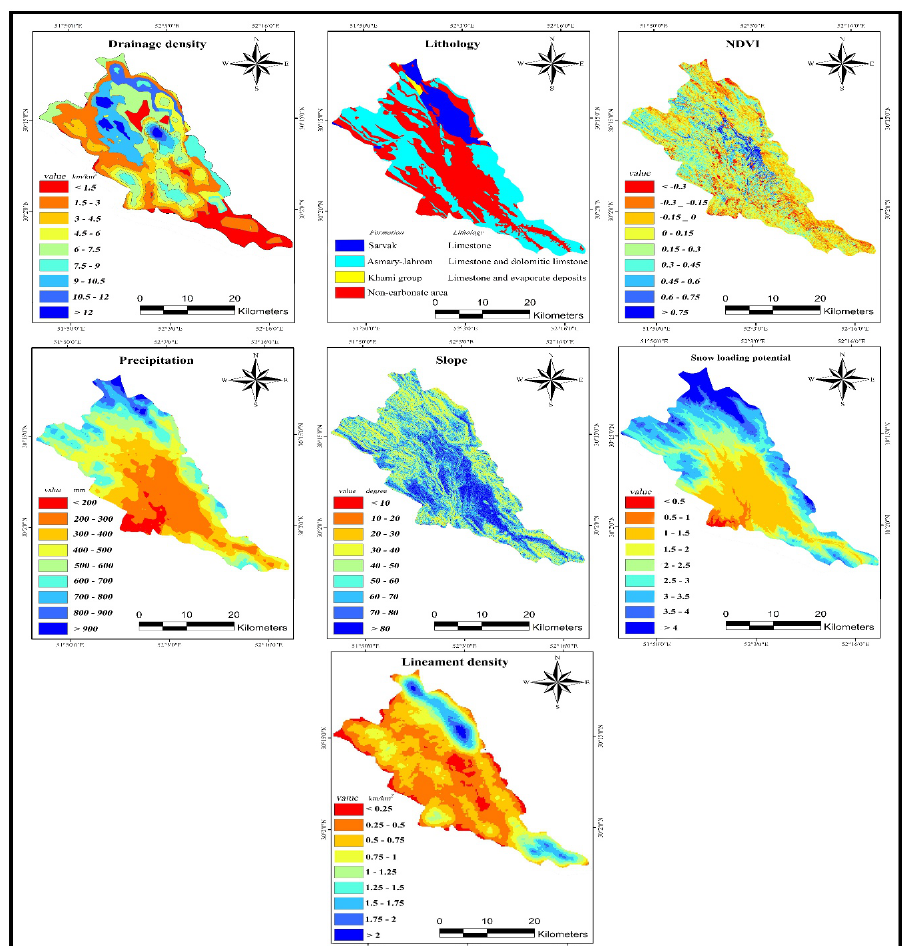
Fig. 4 generated data layers for providing landslide potential